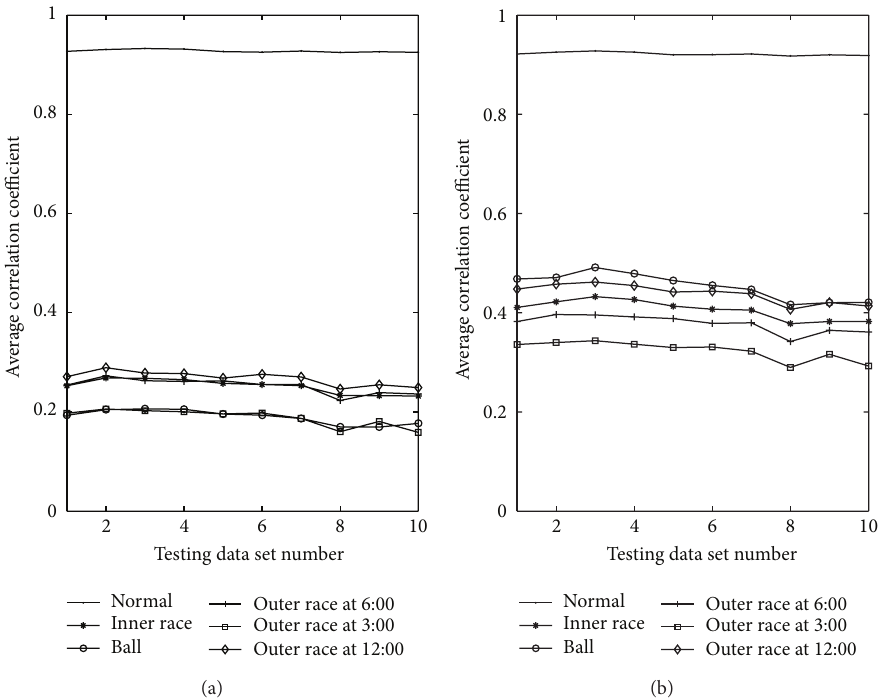
Figure 4: Detection results of bearing under normal condition according to morphology spectrum correlation analysis: (a) signal based triangular SE; (b) flat SE.